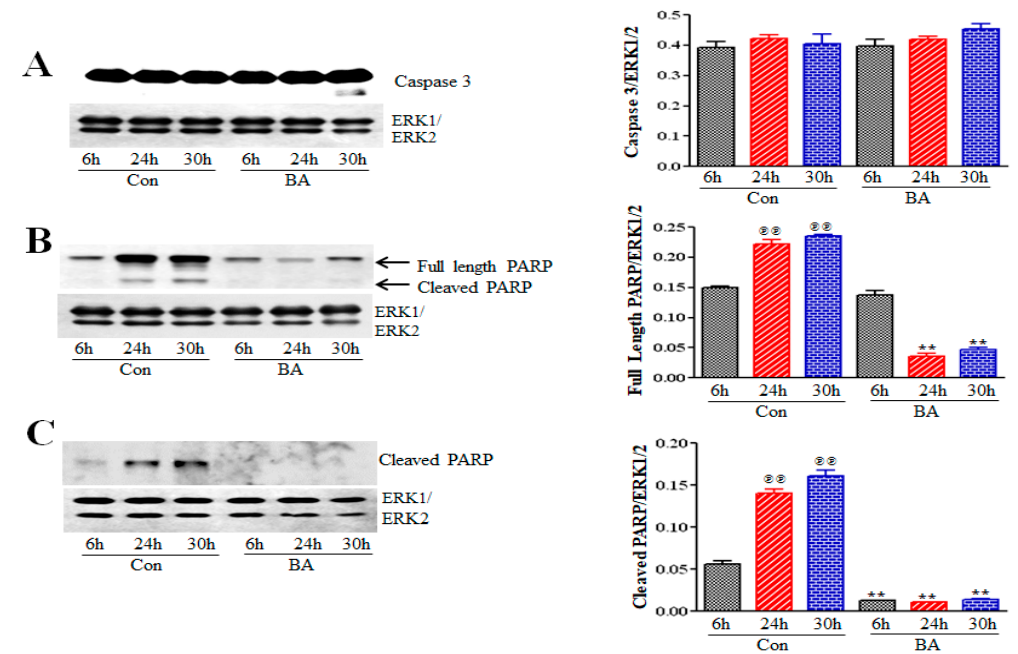
Figure 7. Evaluation of butyrate effect on caspase 3 and PARP in VSMCs. Cell lysates prepared from VSMCs treated with (BA) or without (Con) butyrate were processed for Western blot analyses using antibodies specific to respective proteins. ( A ) Caspase 3 exhibits no activation both in control and butyrate-treated VSMCs except for trace level of cleaved caspase 3 in VSMCs treated with butyrate for 30 h ( B ) Full length PARP was determined by immunoblotting with antibody specific to full length PARP ( @@ p < 0.001 vs 6 h control and ** p < 0.001 vs respective control). ( C ) Cleaved PARP was assessed by probing with antibody specific to cleaved PARP ( @@ p < 0.001 vs 6 h control but no cleaved PARP was detected in treated VSMCs (** p < 0.001 vs respective control).